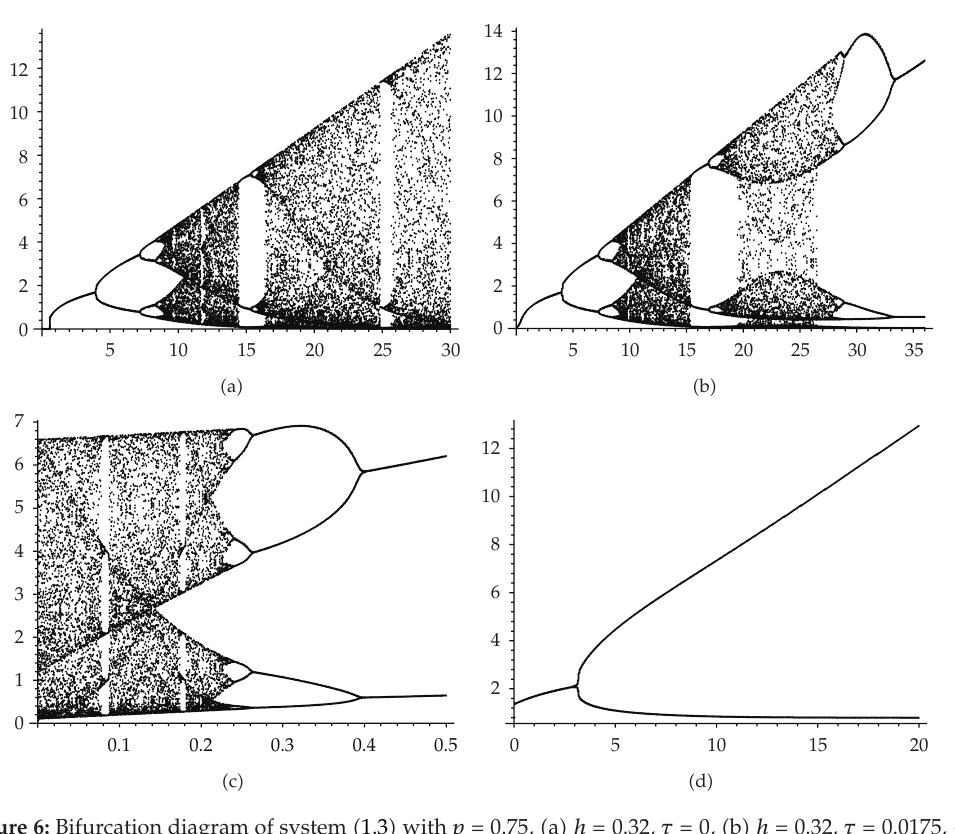
Figure 6: Bifurcation diagram of system (cid:9) 1.3 (cid:10) with p (cid:6) 0 . 75, (cid:9) a (cid:10) h (cid:6) 0 . 32, τ (cid:6) 0, (cid:9) b (cid:10) h (cid:6) 0 . 32, τ (cid:6) 0 . 0175, (cid:9) c (cid:10) h (cid:6) 0 . 32, q (cid:6) 14, (cid:9) d (cid:10) h (cid:6) 0 . 5, τ (cid:6) 0 . 8.